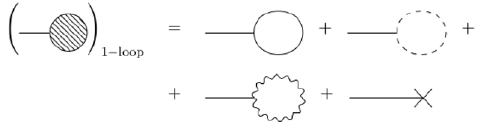
Figure 1 . One-loop diagrams contributing to the one-point Green’s function h h i of the Higgs field h . Curly lines refer to the gauge field, solid ones to the Higgs field and dashed ones to the Goldstone